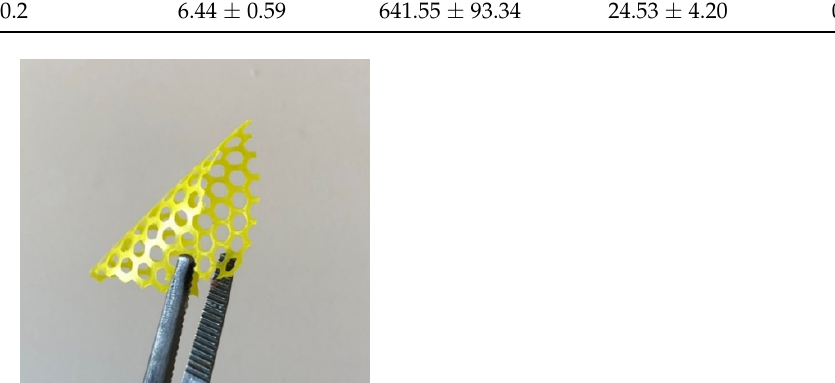
Figure 9. Stress-strain curves of 3D printed scaffolds showing ( a ) the effect of dose and thickness ( b ) the effect of pore shapes.